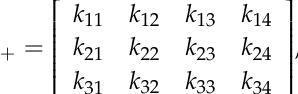
Figure 9. Vectors from the right side of the first equation of the observer for: ( a ) positive speed values